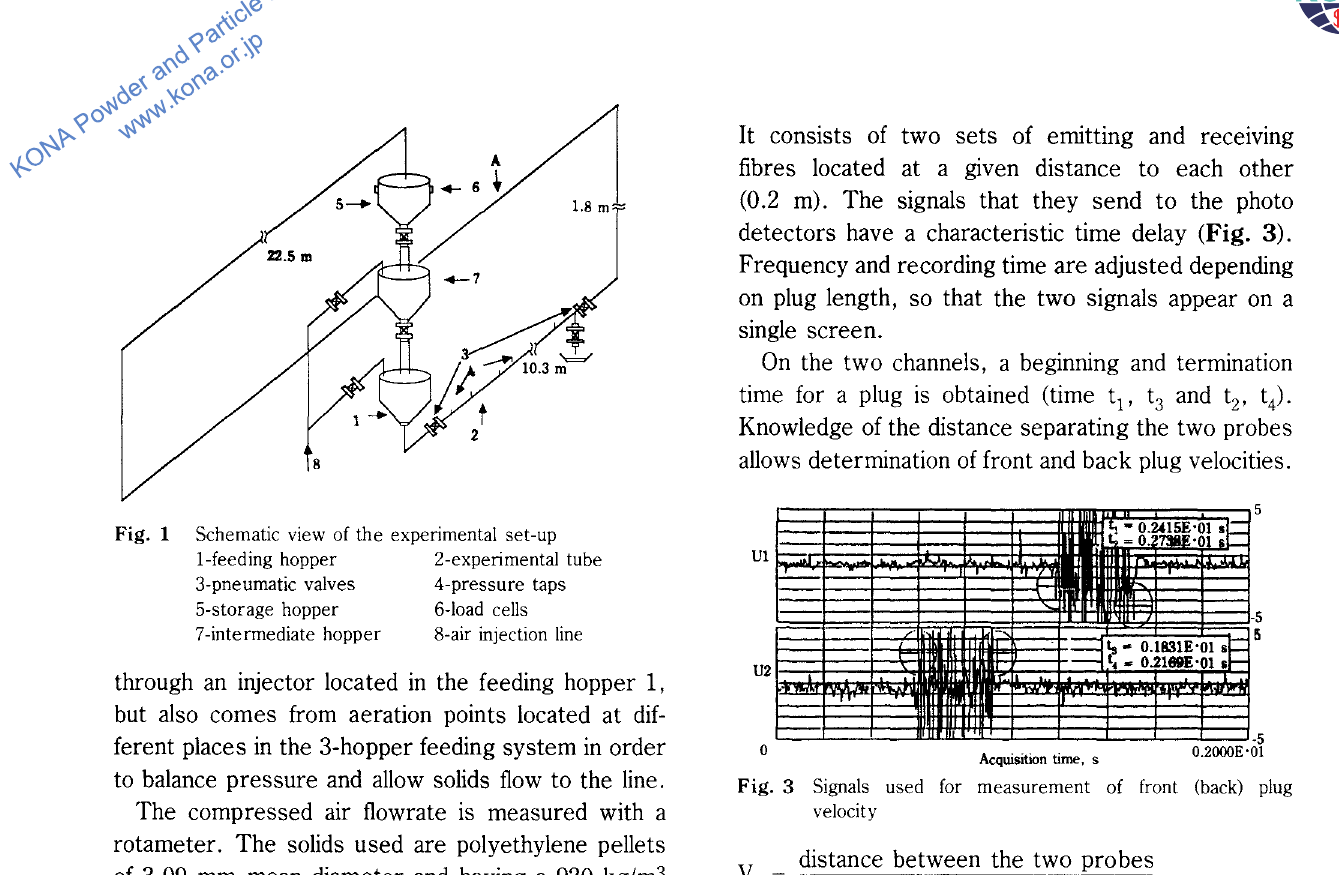
Fig. 1 Schematic view of the experimental set -up 1-feeding hopper 2-experimental tube 3-pneumatic valves 4-pressure taps 5-storage hopper 6-load cells 7-intermediate hopper 8-air injection line